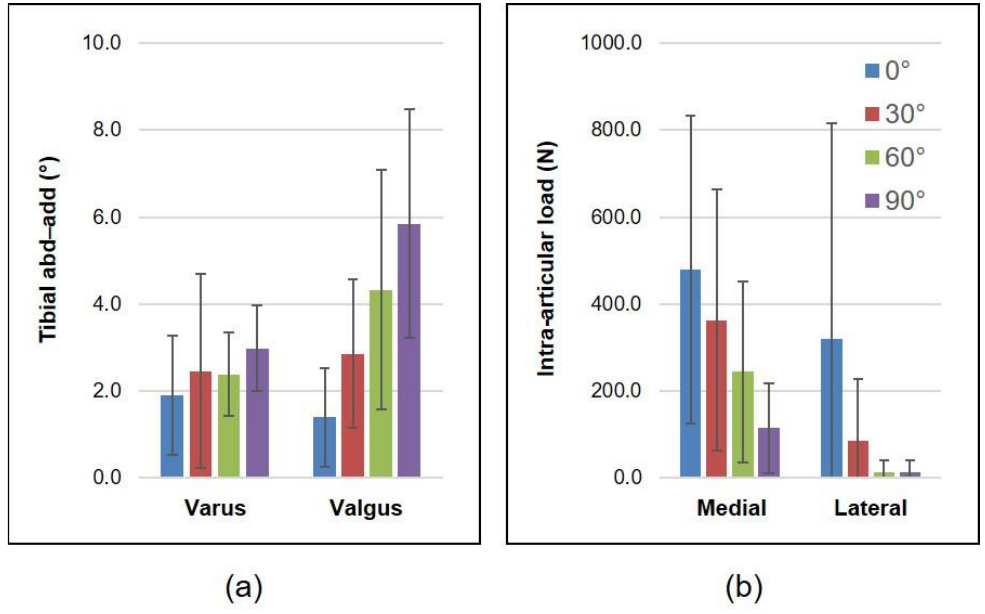
Figure 2. ( a ) Tibial abduction–adduction during the varus and valgus laxity tests measured postoperatively and ( b ) intra- articular loads in the medial and lateral compartments measured intraoperatively for increasing knee flexion angles (data represented as mean ± standard deviation across four specimens). Table 1. Correlating the postoperative tibial abduction measured during the varus (Var) and valgus (Val) stress tests with the intraoperative intra-articular loads in the medial (Med) and lateral (Lat) compartments, respectively, at fixed knee flexion angles (Flex) for e ach specimen and consolidated for the means across all specimen (Pearson’s correlation coeffi- cient (R); statistical significance: p < 0.05). Spec 1